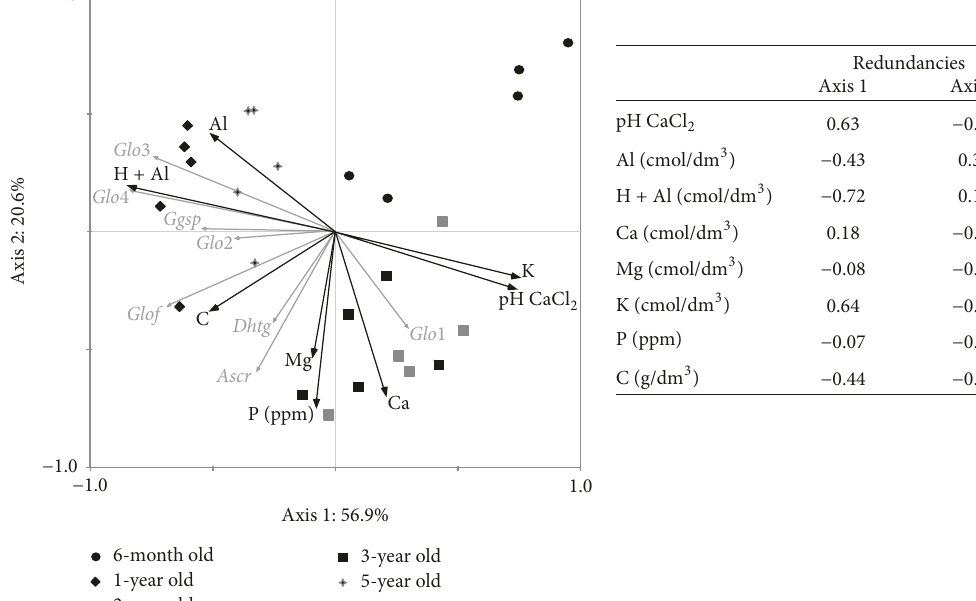
Figure 2: Redundancy analyses with several species of arbuscular mycorrhizal fungi in relation to chemical soil attributes in soil used to produce araucaria seedlings in a nursery of Curitiba, Brazil. Note: Ascr: Acaulospora scrobiculata ; Dhtg: Dentiscutata heterogama ; Ggsp : Gigaspora sp.; Glof : Glomus spinuliferum ; Glo 1: Glomus sp. 1; Glo 2: Glomus sp. 2; Glo 3: Glomus sp. 3; Glo 4: Glomus sp.